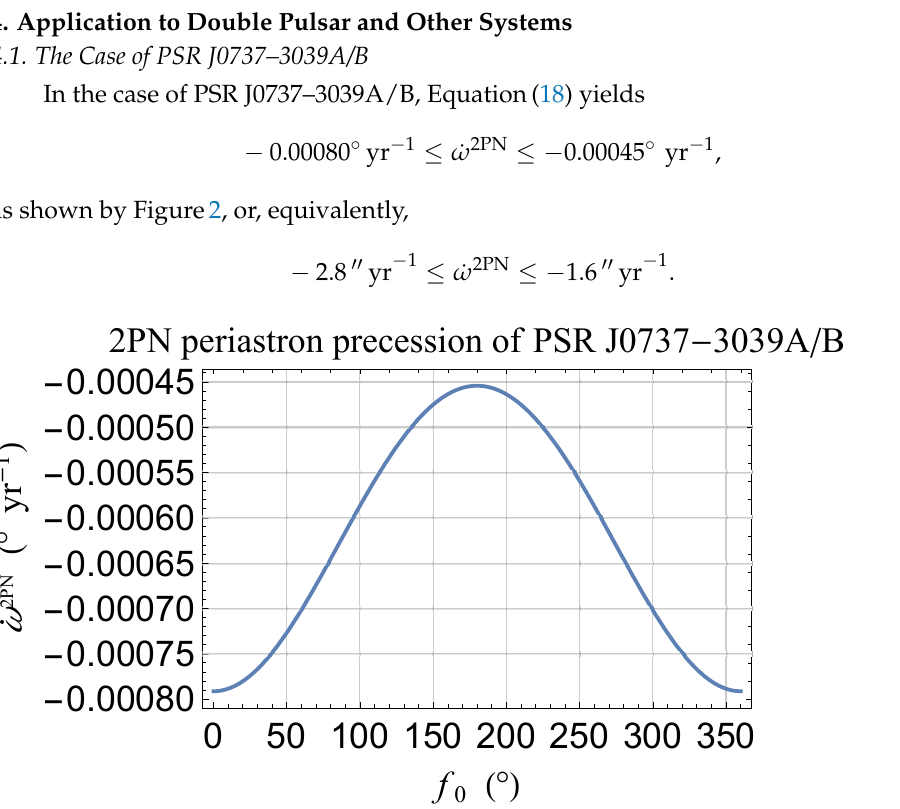
Figure 2. Plot of total 2PN periastron precession of PSR J0737–3039A/B, in ◦ yr − 1 , analytically calculated with Equation(18) as a function of f 0